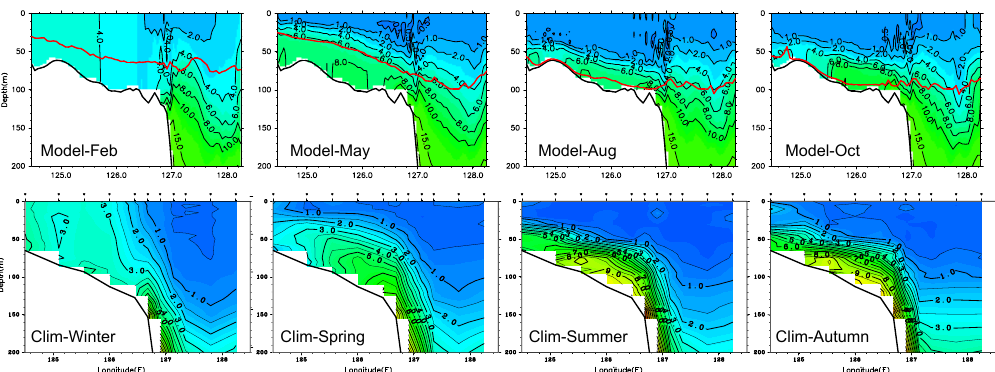
Fig. 6. Simulated (upper panels) and observed (lower panels) distributions of DIN (mmolm − 3 ) along the PN line in four seasons. Red lines in the upper panels denote euphotic depth.